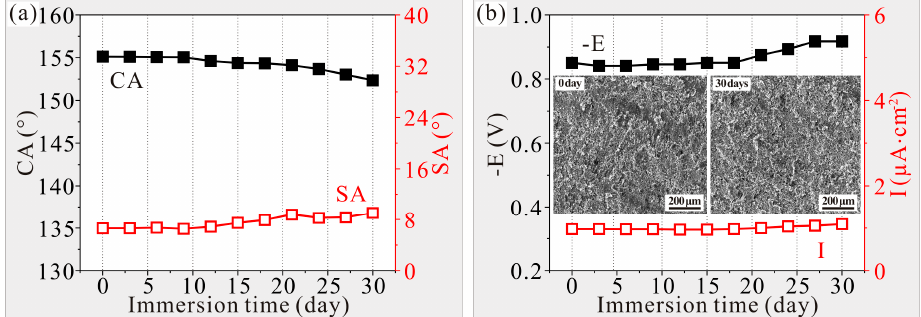
Figure 10. Effects of immersion time in seawater on ( a ) wettability and ( b ) corrosion resistance of modified deposited sample. The inserts in ( b ) referring to SEM images of modified deposited